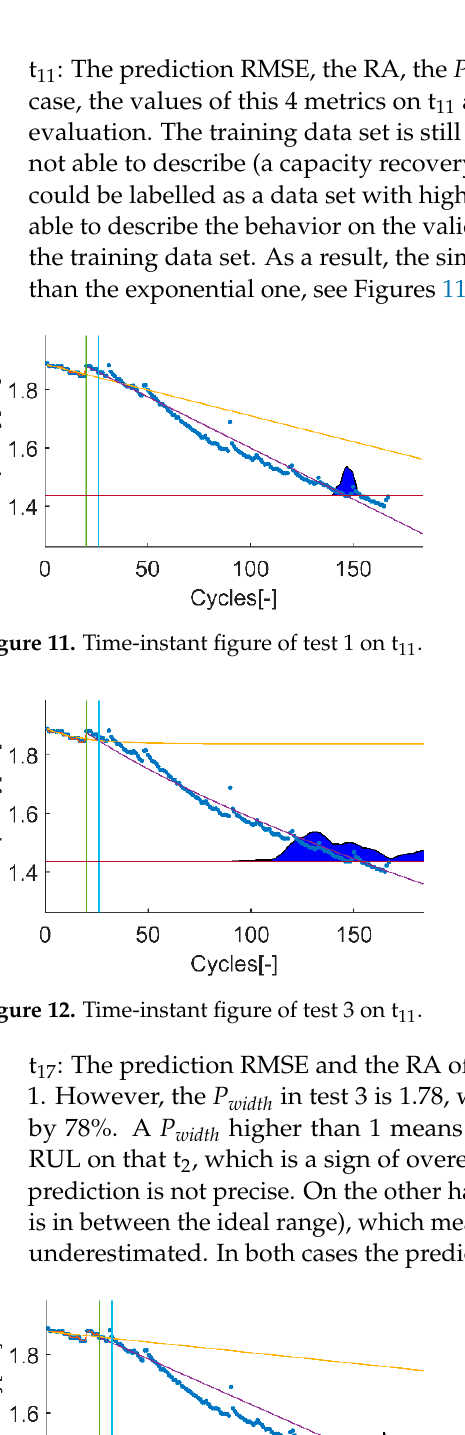
Figure 10. Time-instant figure of test 3 on t 4 .